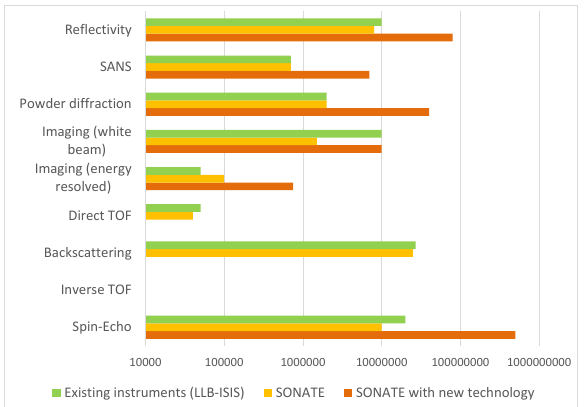
Fig. 5. Comparison of the performances of different scattering techniques in terms of flux at the sample position (n/cm²/s). (green) reference instruments at various facilities (LLB or ISIS) ; (yellow) move of the existing instruments from Orphée to SONATE ; (orange) performances after technical upgrades. The figures for the inelastic instruments (Direct TOF and Backscattering) have been taken from [7].